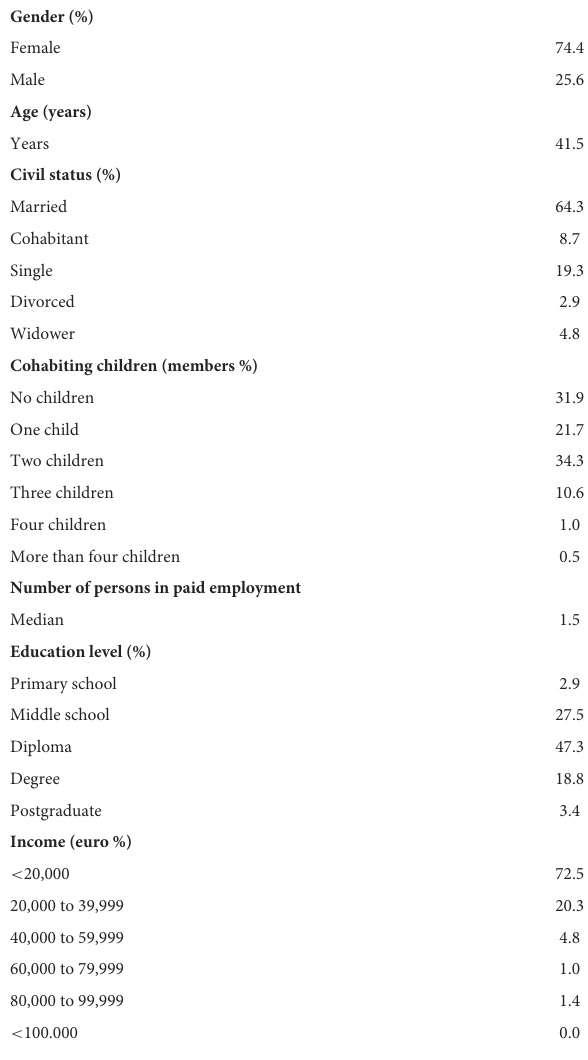
TABLE 1 Main socio-demographic characteristics of the interviewed